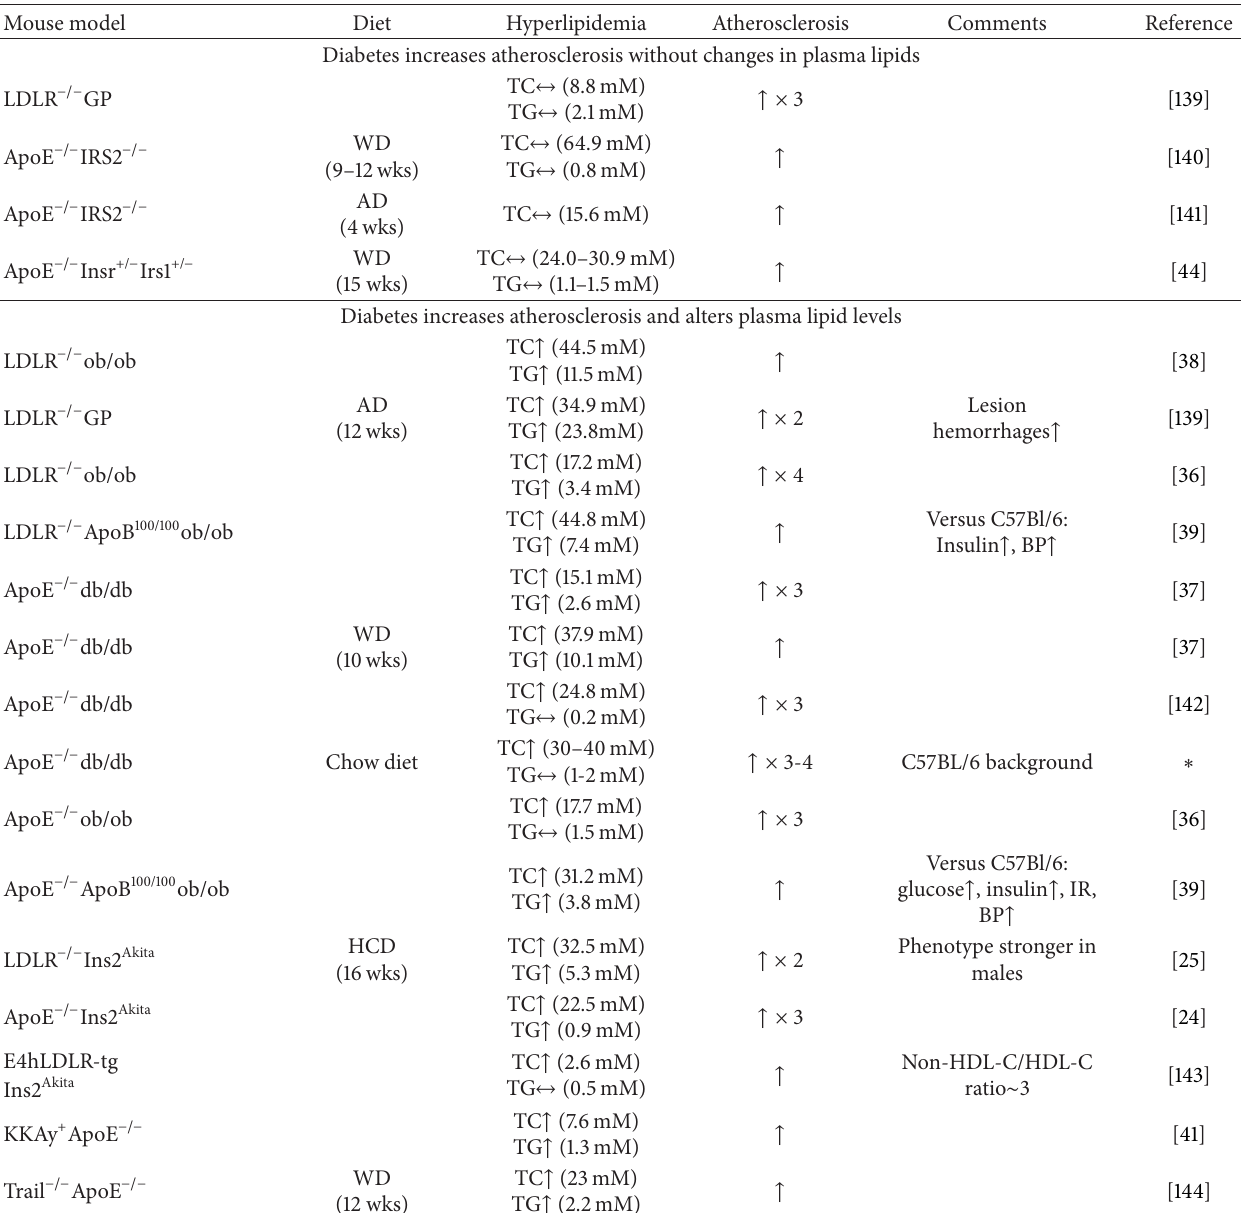
Table 4: Atherosclerotic mouse models with increased atherosclerosis after genetically induced